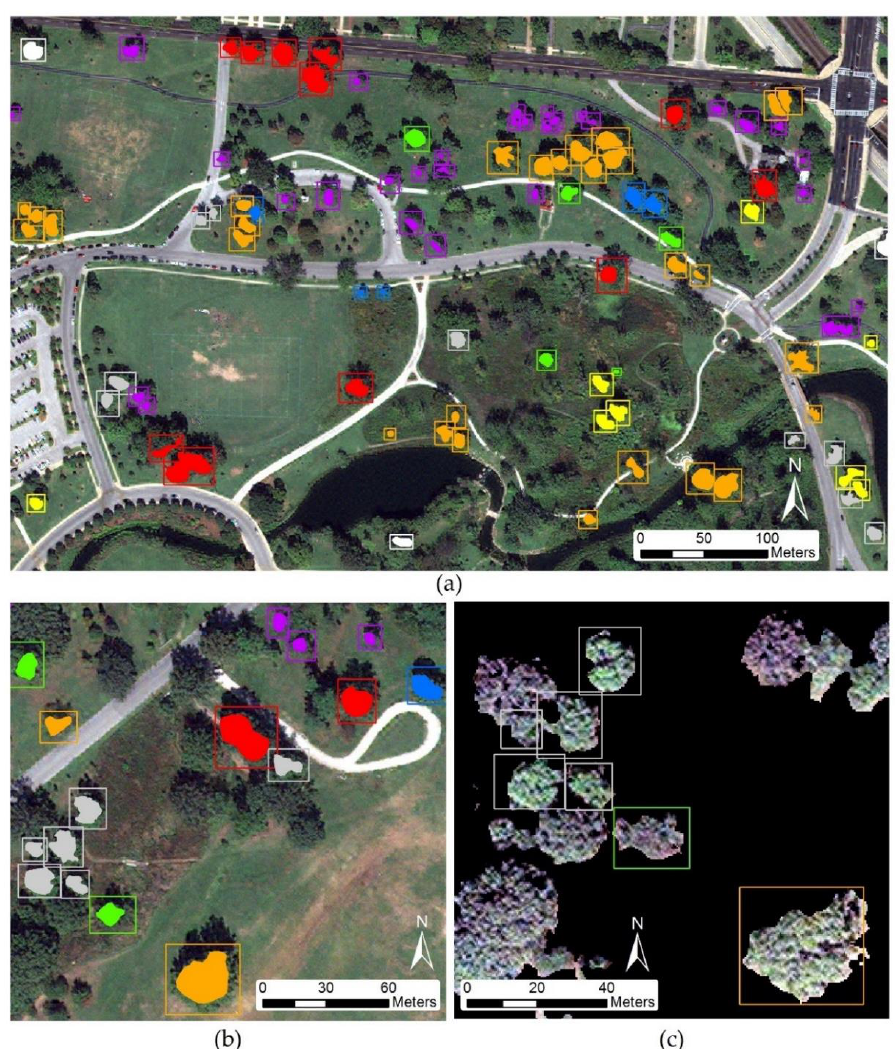
Figure 2. Manually delineated ground truth samples of dominant tree species within study area. ( a ) Small scale view of tree species reference sample subset. ( b ) Large scale view of reference samples for individual tree canopies. ( c ) Individual tree species samples after background removal.